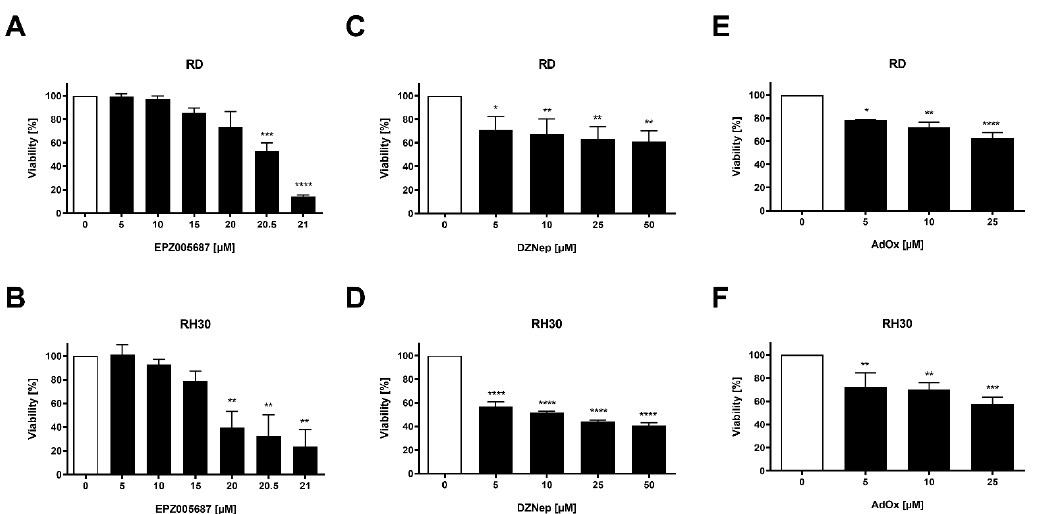
Figure 2. Effect of the EZH2 inhibitors on cell viability in RMS cell lines. Relative numbers of viable RD (upper row) and RH30 (lower row) cells following a 72 h incubation in the absence (white bars) and presence (black bars) of increasing concentrations of EPZ005687 ( A , B ), DZNep ( C , D ), and AdOx ( E , F ). The untreated control was set as 100%. Error bars represent mean +/ − SEM ( n ≥ 3). p * ≤ 0.05, p ** ≤ 0.01, p *** ≤ 0.001, p **** ≤ 0.0001 indicates statistical significance.